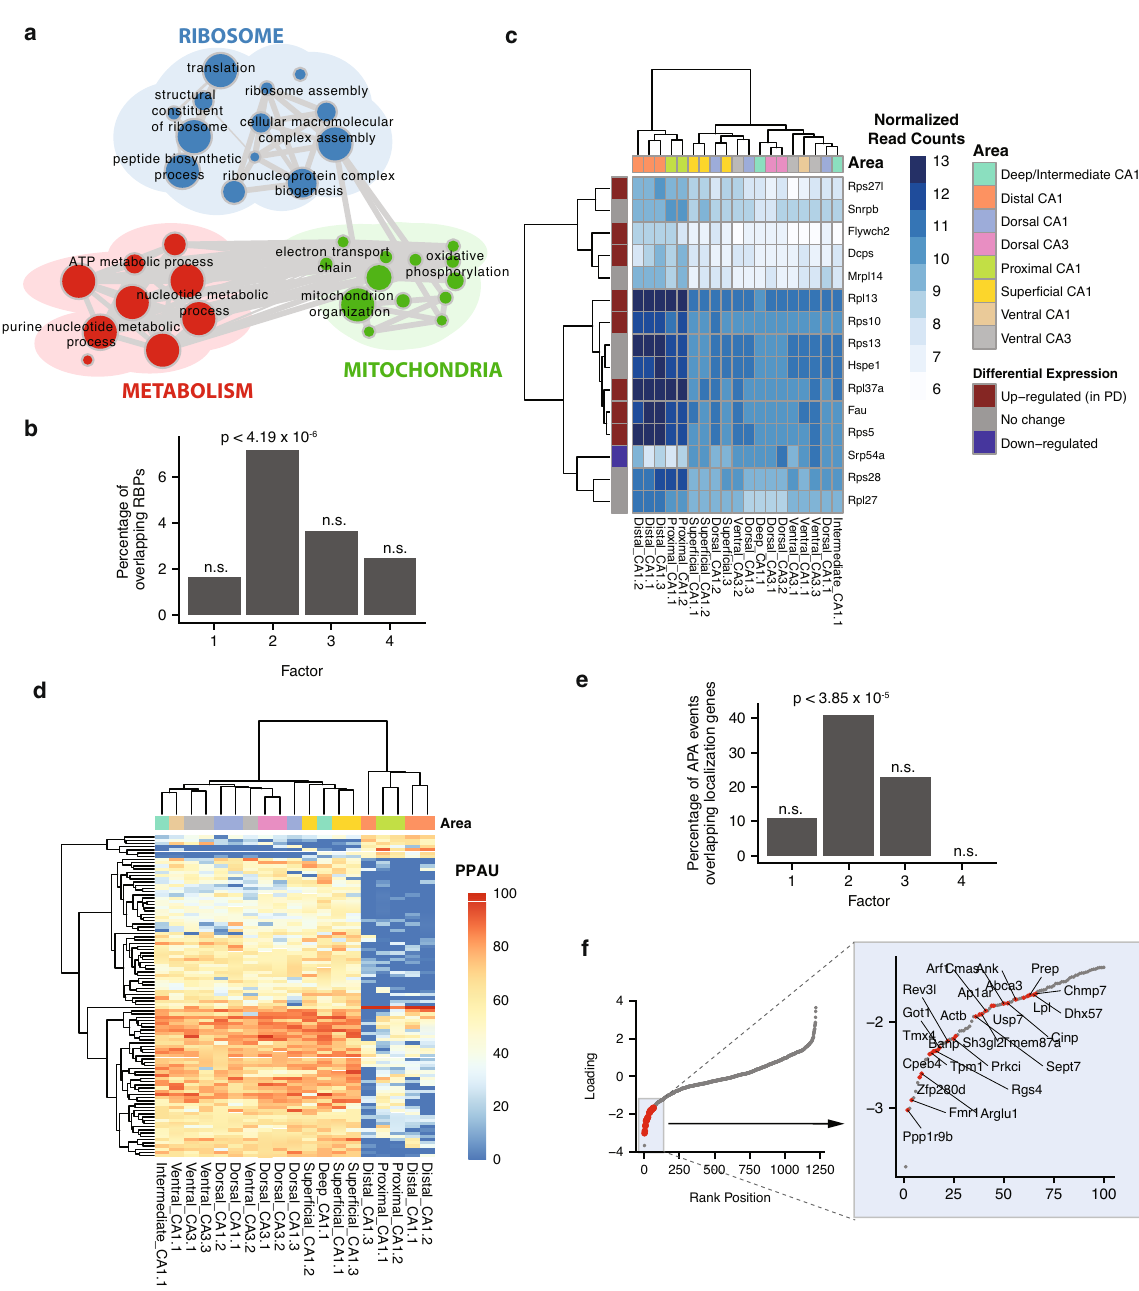
Fig. 3 GE and APA changes in LF2 distinguish proximal-distal neurons from other axes. a Enrichment map displaying the functional enrichment analysis of genes from top GE events with the largest absolute LF2 loading. See Fig. 2c for description of enrichment maps. b Bar-plot showing the proportion of top- weighted genes that overlap known RNA-binding proteins (RBPs). When comparing the degree of overlap between each latent factor and known RBPs, only LF2 has a signi fi cant overlap (27/298, p = 4.19 × 10 − 6 , hypergeometric test). n.s.: not signi fi cant. c Heatmap showing normalized read counts of top 15 RBPs (rows) observed in LF2 for each sample (columns). Each gene is annotated according to its differential expression status between proximal-distal and dorsal-ventral-super fi cial-deep neurons (left vertical bar). Each sample is annotated according to region (top horizontal bar) and sample names are as in Fig. 2b. PD = proximal-distal neurons. d Heatmap showing the APA pro fi les inferred by QAPA, measured by proximal poly(A) site usage (PPAU), of the top-weighted 3 ′ UTRs (rows) for each sample (columns). e Bar-plot showing the proportion of top-weighted 3 ′ UTRs from each latent factor with genes known to localize to dendrites and axons 46 . Similar to b , when comparing the degree of overlap between each latent factor and known localization genes, only LF2 had a signi fi cant overlap (27/66, p = 3.85 × 10 − 5 , hypergeometric test). Sample names are as in Fig. 2b. n.s.: not signi fi cant. f Scatterplot showing the latent factor 2 loadings ( y -axis) for each 3 ′ UTR in ascending order from left to right ( x -axis). Lengthening 3 ′ UTRs (indicated by negative loadings, Supplementary Fig. 3A) that belong to localized transcripts are represented by red dots. The bottom-right box shows genes with localized transcripts from the indicated region of the